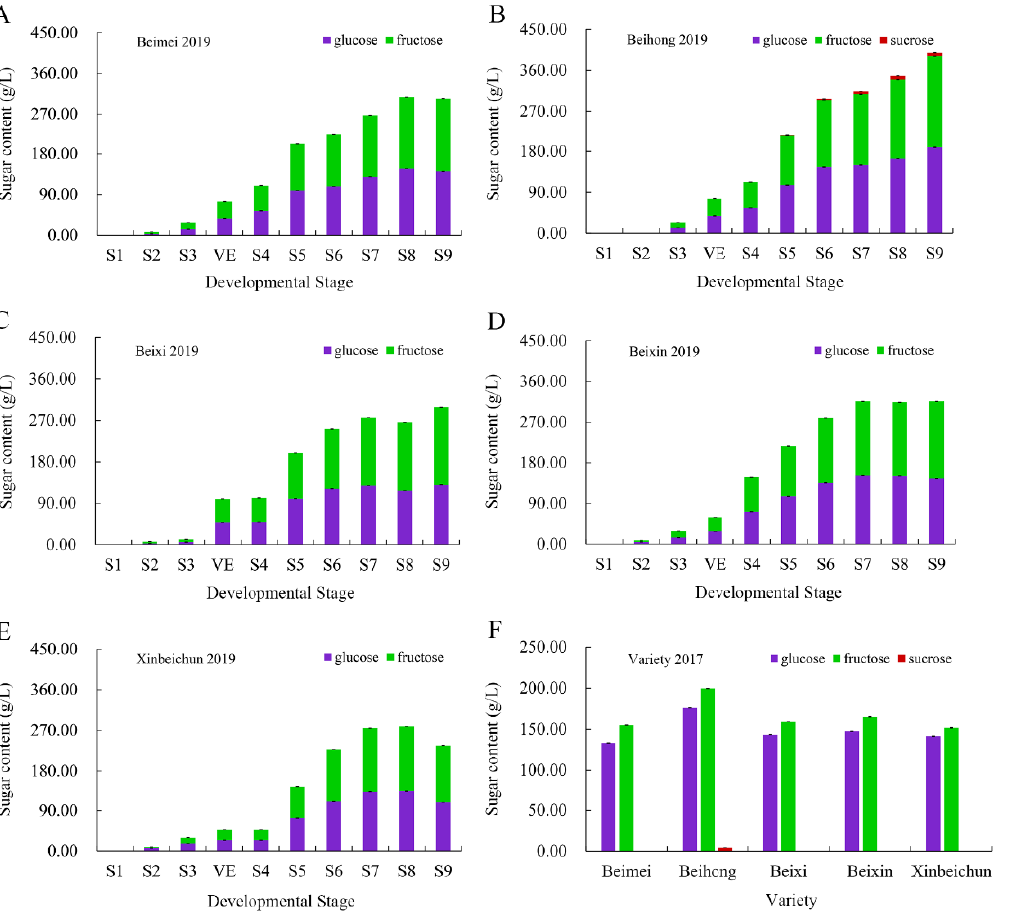
Figure 6. Changes of sugar content of ‘Beimei’ ( A ), ‘Beihong’ ( B ), ‘Beixi’ ( C ), ‘Beixin’ ( D ) and ‘Xinbeichun’ ( E ), ‘Variety’ ( F ). S1 sampling date was 19 June 2019. S2 sampling date in 2021 was 8 July. S1–S9 were sampled once every two weeks, VE = veraison. Data are mean values of three replicates, the error bars indicate the SE from triplicate repeats.